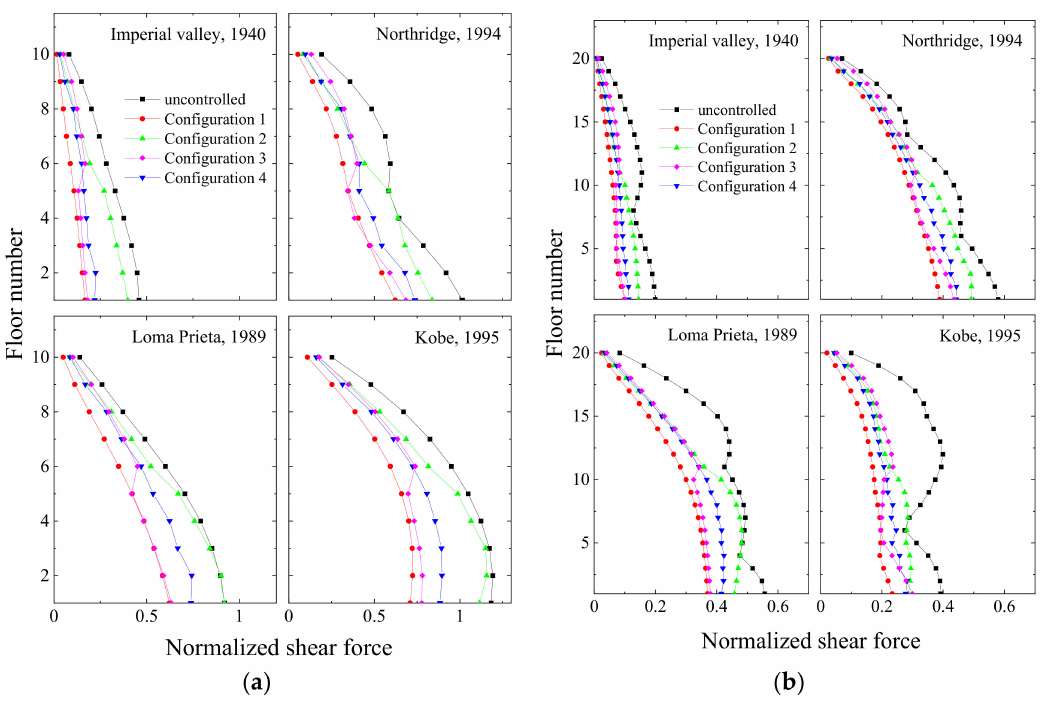
Figure 16. Peak floor shear force under different damper configurations in: ( a ) a coupled stiff building and ( b ) a coupled flexible building under semi-active control of the MR damper.